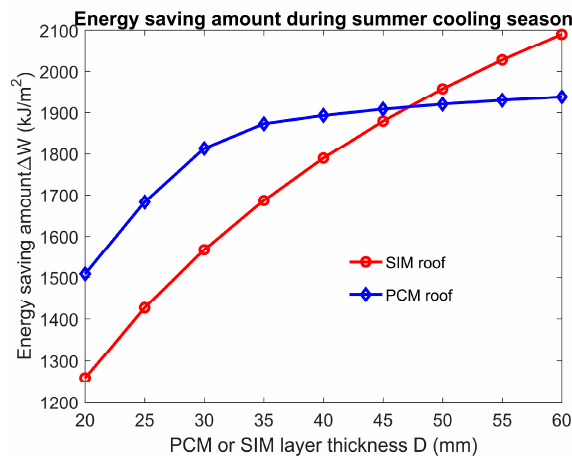
Figure 9. The effect of layer thickness on the energy saving amount of PCM or SIM roofs during the summer cooling season.